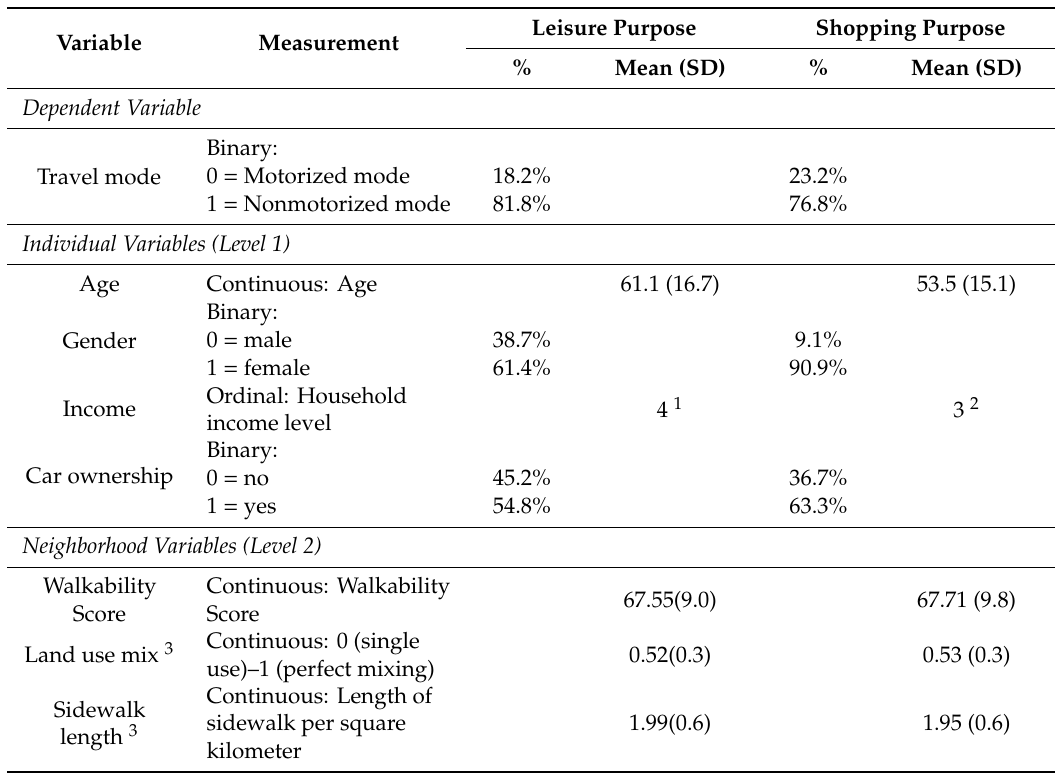
Table 2. Descriptive statistics of